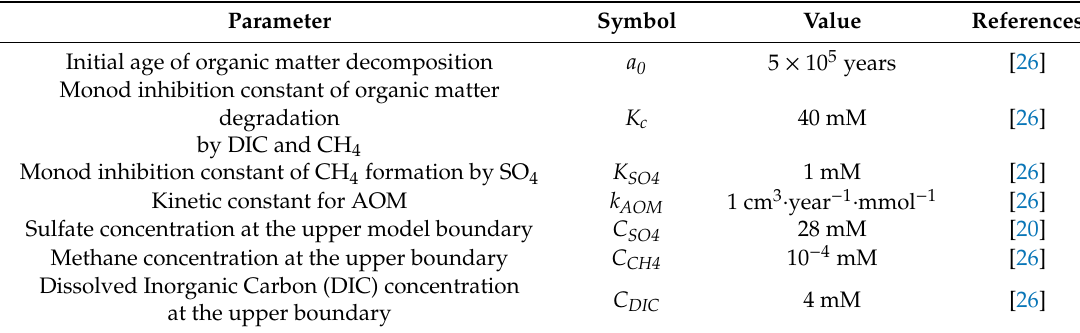
Table 4. Geochemical parameters used in numerical modeling scenarios for Site 997 (see further description in